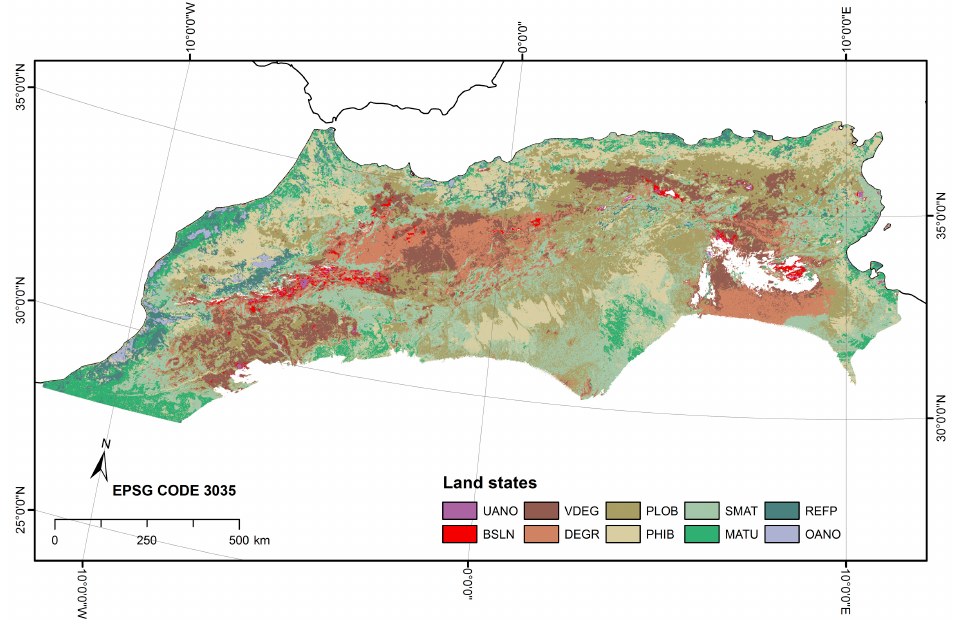
Figure 4. Land condition states in the NW Maghreb drylands (1998–2008). Legend abbreviations: